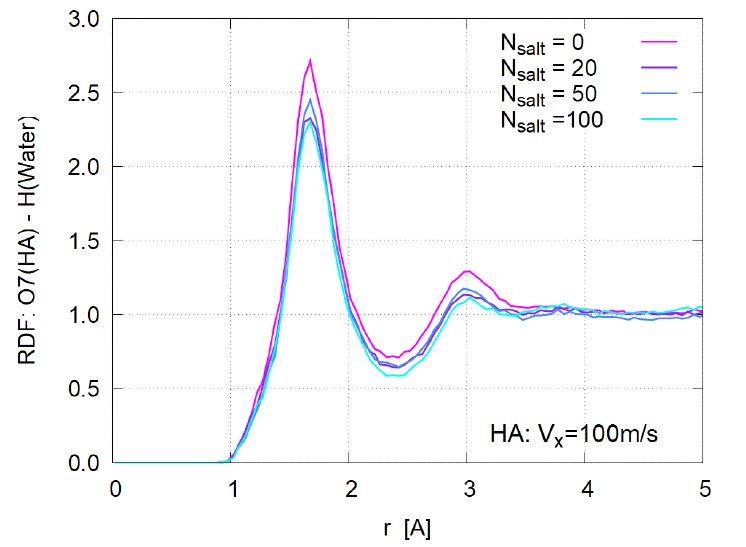
Figure 14. Atom-atom radial distribution function for HA system for V x = 100m/s case.